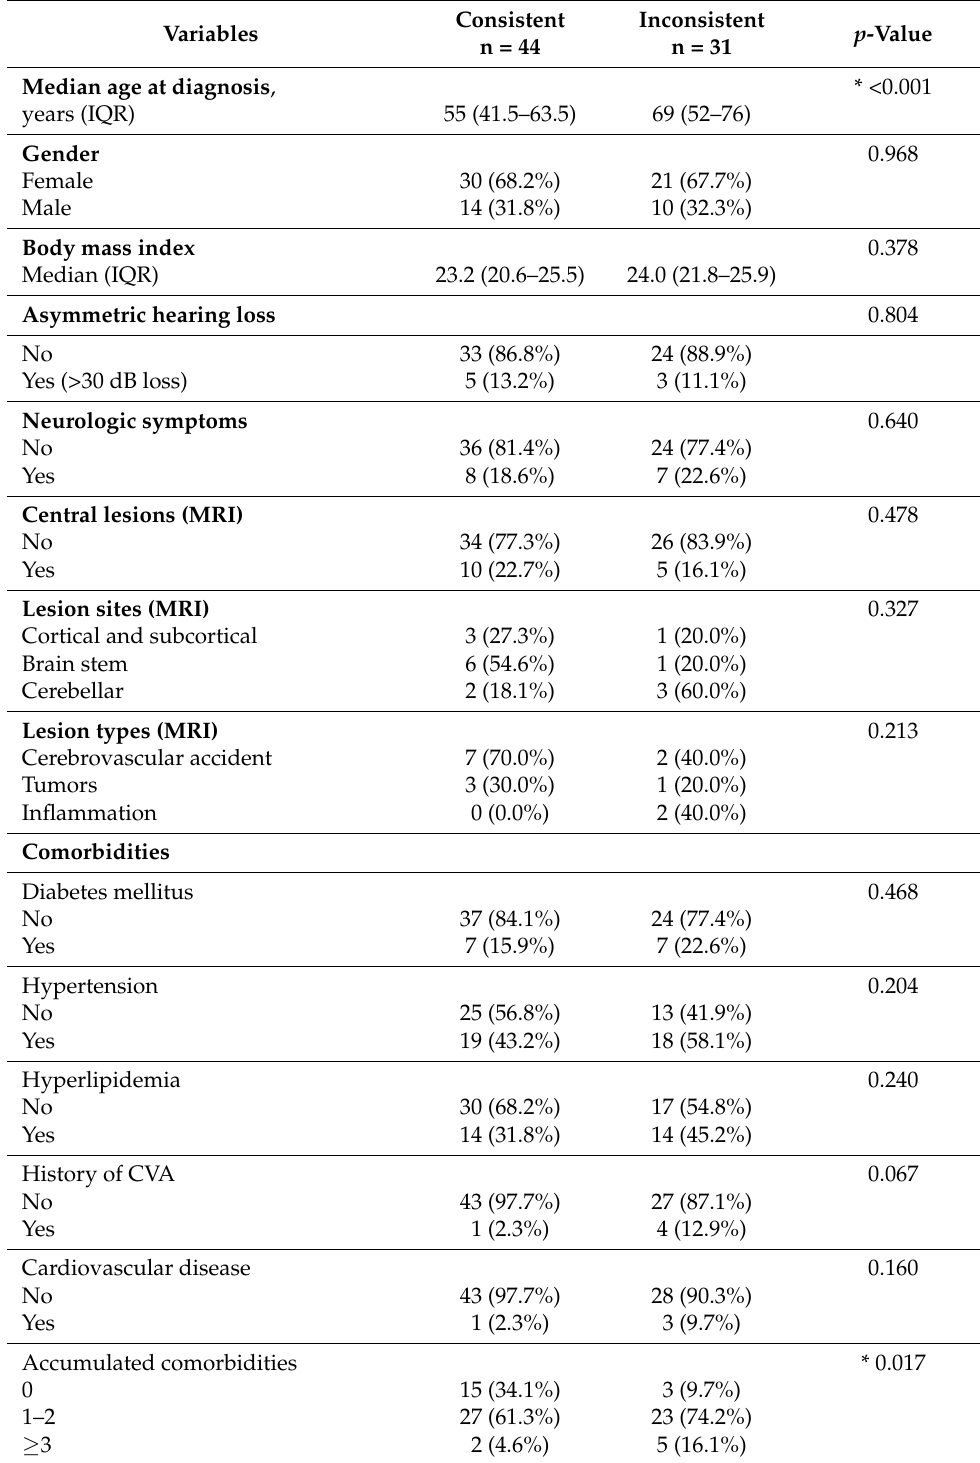
Table 3. Demographic and clinical characteristics of patients whose oculomotor tests were consistent and inconsistent with the MRI findings ( n =